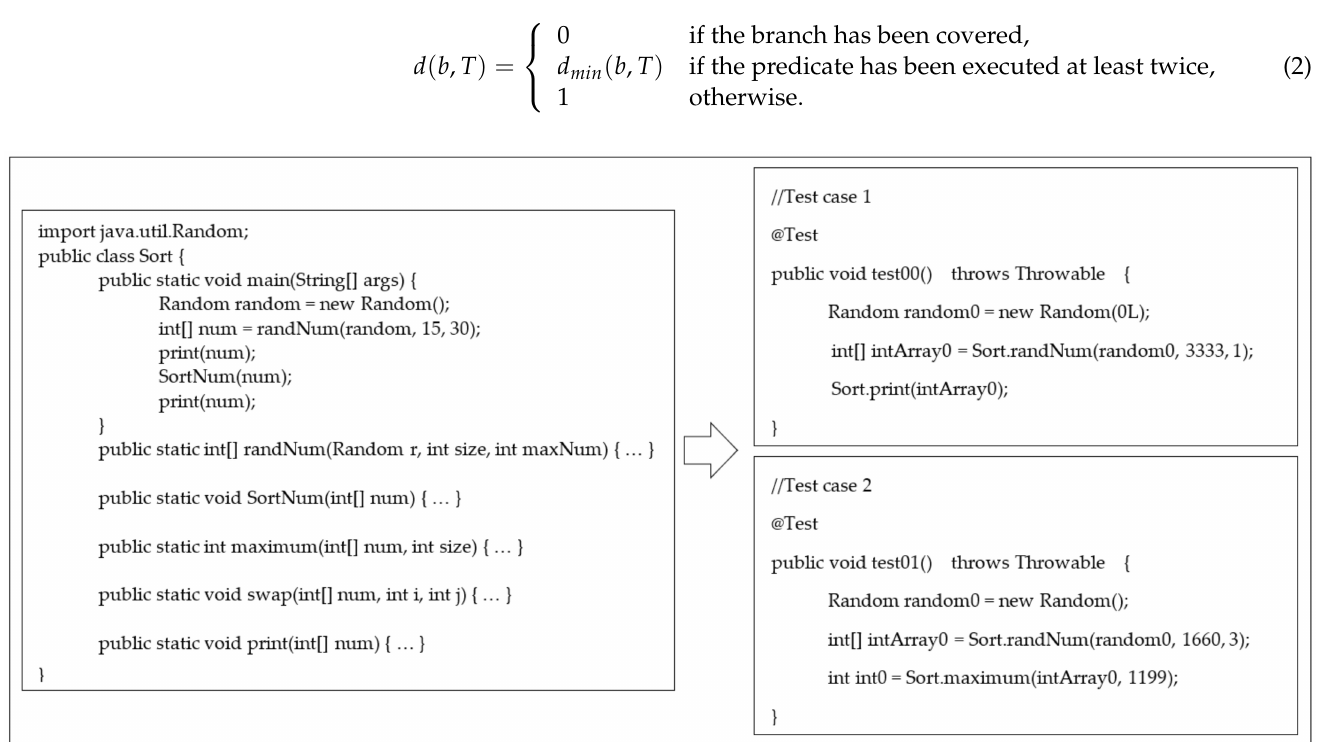
Figure 1. Generated test cases from source